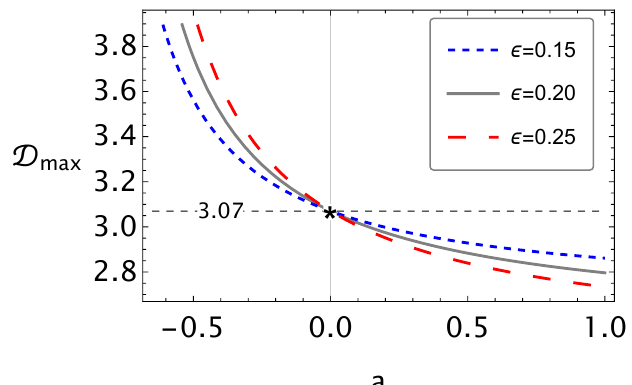
Figure 7. Maximum values of D as a function of the EU parameter for several values of the compact- ness parameter of NSs. The symbol * implies general relativistic